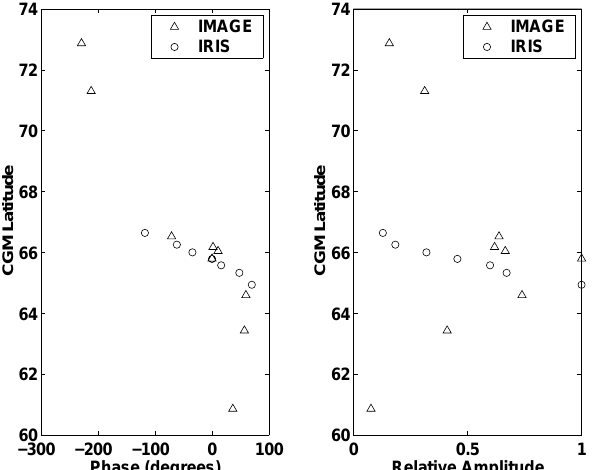
Fig. 3. Amplitudes and phases of absorption and magnetic X - components for Event 1.